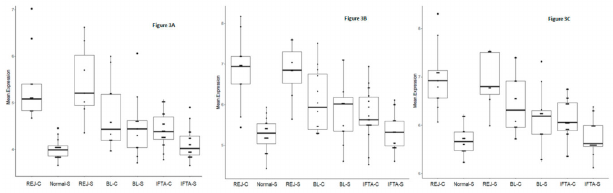
Figure 3. Rejection gene score according to the most di ff erentially expressed genes in Venner et al. [23], Khatri et al. [4], and Wang et al. [5] applied to our set of biopsies (( A – C ) respectively). REJ-C, rejection in biopsies for cause ( n = 12); Normal-S, normal surveillance biopsies ( n = 17), REJ-S, rejection in surveillance biopsies ( n = 6); BL-C, borderline changes in biopsies for cause ( n = 13); BL-S, borderline changes in surveillance biopsies ( n = 12); IFTA-C, interstitial fibrosis and tubular atrophy in biopsies for cause ( n = 20); IFTA-S, interstitial fibrosis and tubular atrophy in surveillance biopsies ( n = 16). ANOVA p -value 9.46 × 10 − 10 , 2.16 × 10 − 9 , 5.08 × 10 − 10 for graphs ( A – C );